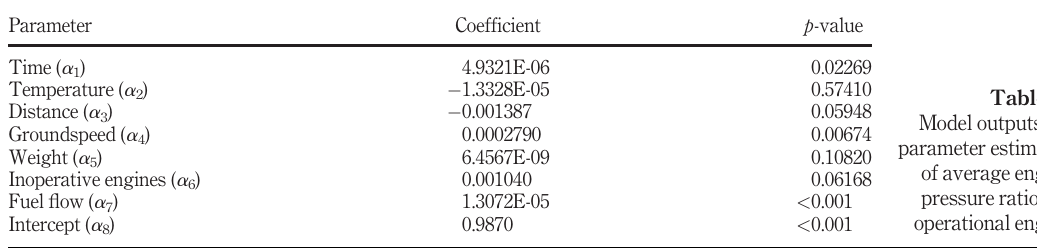
Table 2. Model outputs